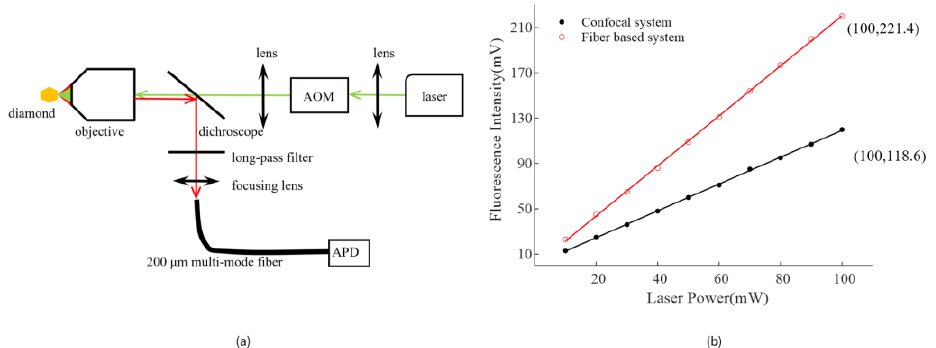
Figure 2. ( a ) Setup of the confocal system, a diameter of 200 μm multi-mode fiber was used as a pinhole. ( b )The fluorescence intensity I 0 as function of laser source power in confocal system and fiber-based system. The same micro-diamond was used to reduce the influence of diamond morphology. The fluorescence intensity is described using APD output voltage value.